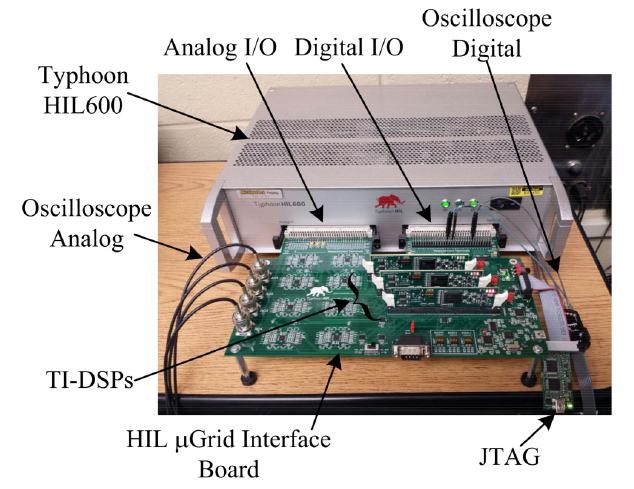
Figure 5. Typhoon HIL600 with microgrid control board and three TI-F28335 DSP ControlCARDs (two cards were used for this paper). HIL, Hardware-In-the-Loop. Table 2. HIL analog output configuration. AO, Analog